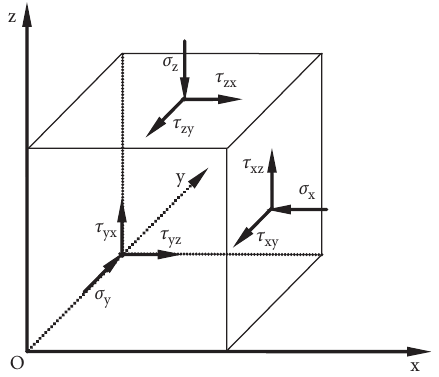
Figure 1: Stress state diagram of a point in rock